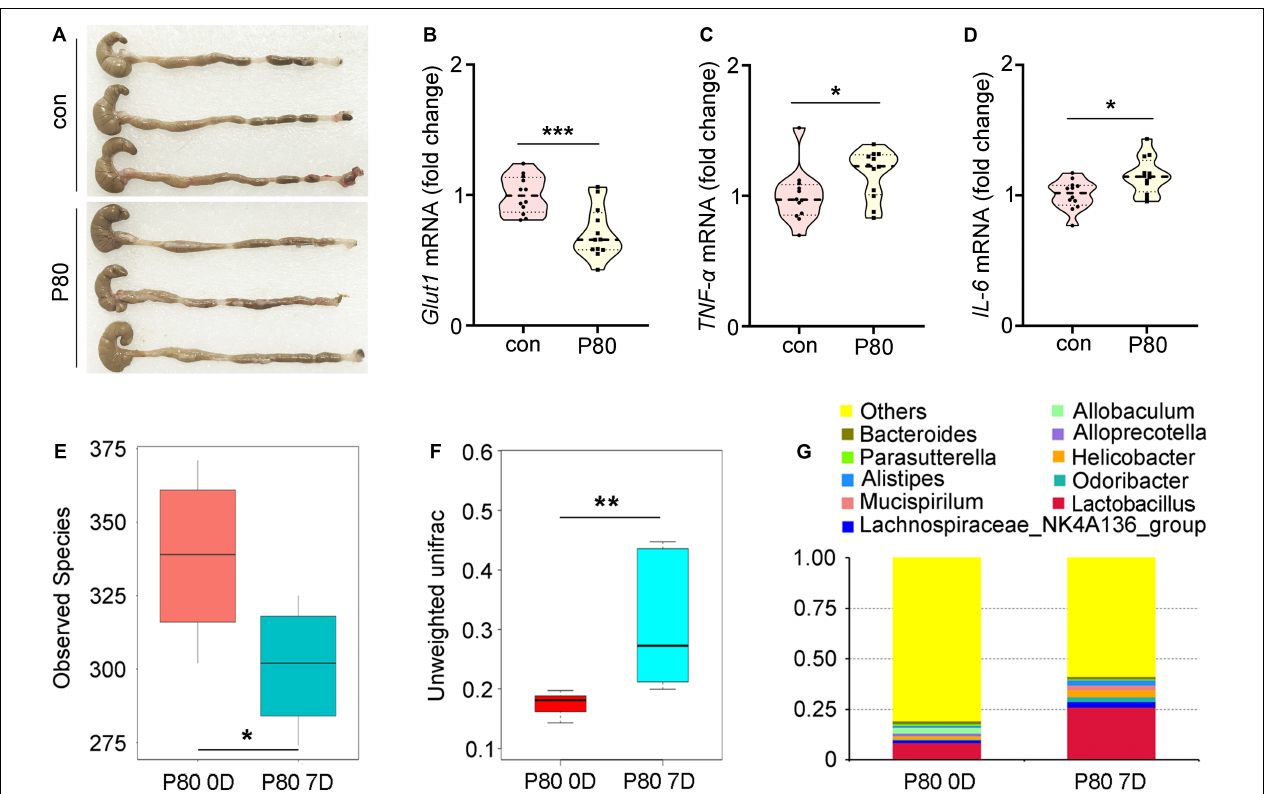
FIGURE 1 | P80 consumption promotes intestinal inflammation and alters the gut microbiota. (A) The length of colon tissues from mice with or without consumption of P80 by oral gavage was shown. (B–D) The expression levels of Glut1 (B) , TNF- α (C) and IL-6 (D) in small intestines were examined by qRT-PCR. Significant differences are indicated: * p < 0.05, *** p < 0.001; Student’s t -test, n = 12 per group. (E) The observed species number of intestinal bacteria in mice before and after 7 days of consumption of P80 was examined by 16S rRNA high throughput sequencing. The top and bottom boundaries of each box indicate the 75th and 25th quartile values, respectively, and lines within each box represent the 50th quartile (median) values. Ends of whiskers mark the lowest and highest diversity values in each instance. Statistically significant differences are indicated: * p < 0.05; TukeyHSD, n = 5. (F) The β diversity of intestinal bacteria in mice before and after 7 days of consumption of P80 was examined by 16S rRNA high throughput sequencing. Statistically significant differences are indicated: ** p < 0.01; TukeyHSD, n = 5. (G) The relative abundances of enteric bacteria at the phylum level in mice before and after 7 days of consumption of P80 were assessed using 16S rRNA high throughput